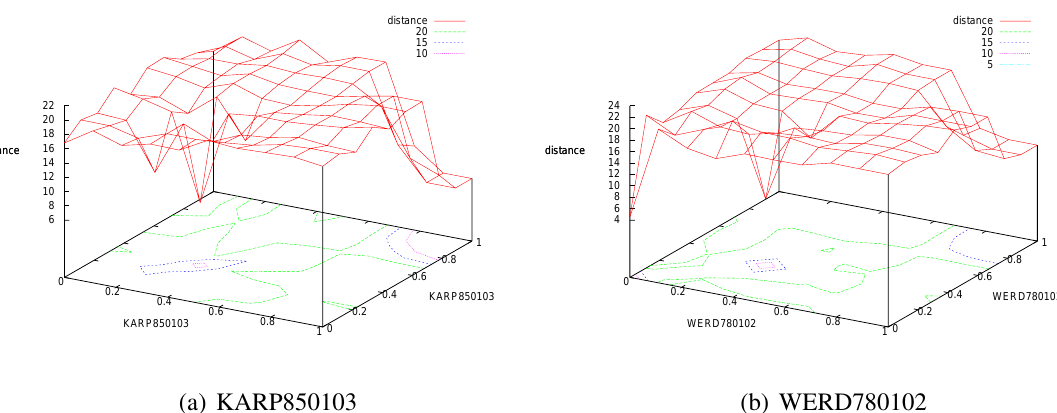
Figure 6: Pattern type: “corner-biased surfaces”. The 3D surface represents the mean distances among pairs of amino acids according to properties (a) KARP850103 and (b) WERD780102.